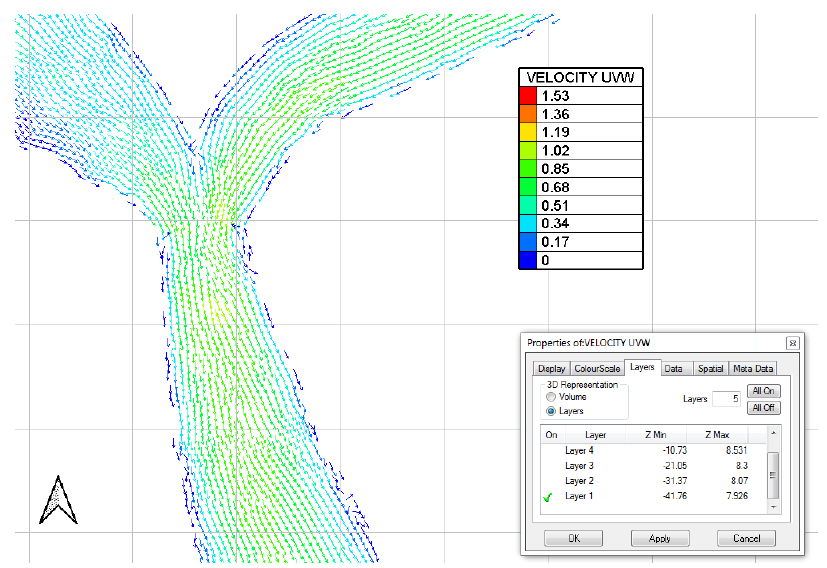
Figure 11. Average flow velocity (VELOCITY UV) in the flood season in 2017 at the bottom (m/s).